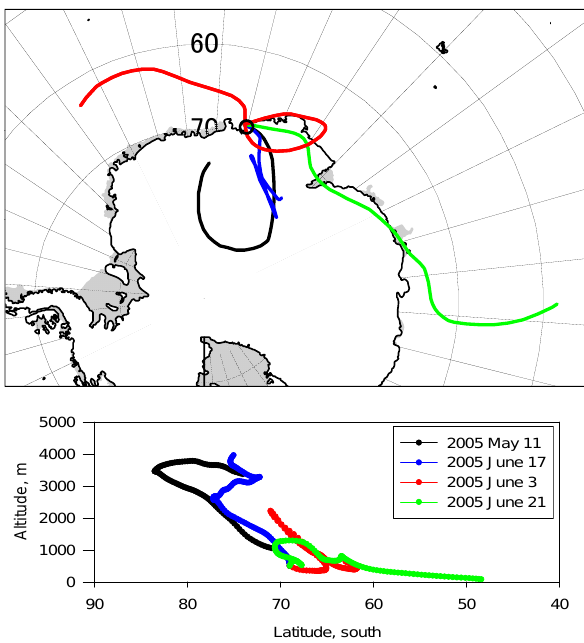
Fig. 10. 5-day backward trajectories in the lower and higher number fraction of non-volatile particles during the winter at Syowa Station. Circles mark the location of Syowa Station.